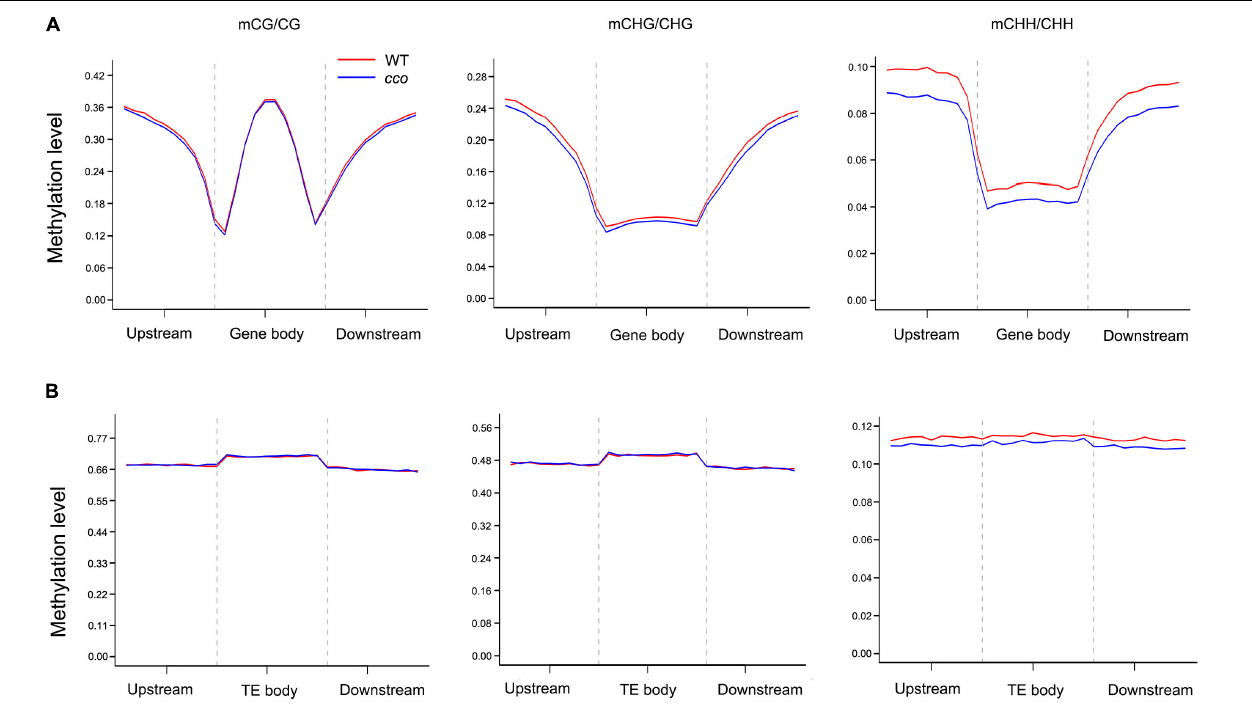
FIGURE 4 | DNA methylation patterns of gene body and transposon regions in soybean cotyledons of the WT and the cco mutant. (A) Methylation levels of CG, CHG, and CHH contexts are displayed for each bin within gene body regions and their 2-kb up- and downstream regions. (B) Methylation levels of CG, CHG, and CHH contexts are displayed for each bin within transposons and their 2-kb up- and downstream regions. Gene body and transposon regions (with their flanking regions) were all equally divided into 20 bins. The methylation level of each bin is shown on the Y